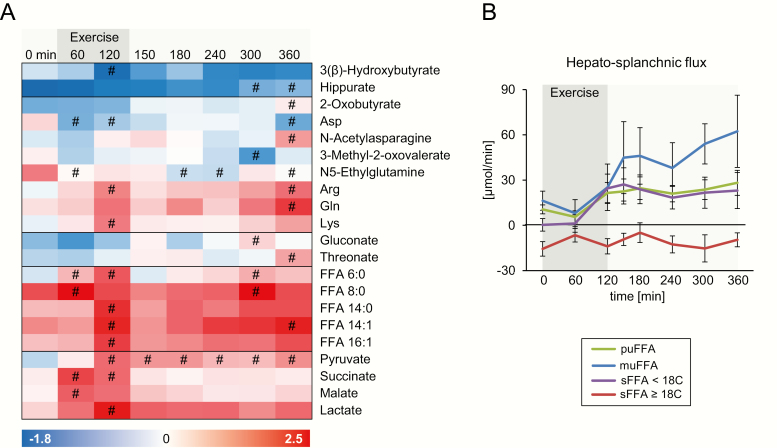
Effects of exercise on the hepato-splanchnic flux of metabolites. 3A: Metabolites exhibiting significant changes in uptake (positive values, red) or release (negative values, blue) from the hepato-splanchnic bed. Each column represents unit variance (UV)-scaled values of the mean of all participants. Metabolites were ordered according to pathway and kinetics. 3B: Hepato-splanchnic flux of free fatty acids (FFA) quantified by UHPLC-Q-TOF/MS, summed up according to chain length and saturation (Abbreviations: mu, mono-unsaturated; pu, poly-unsaturated; s, saturated FFA) presented as mean ± standard error (SEM). #: significantly different from 0 minutes.